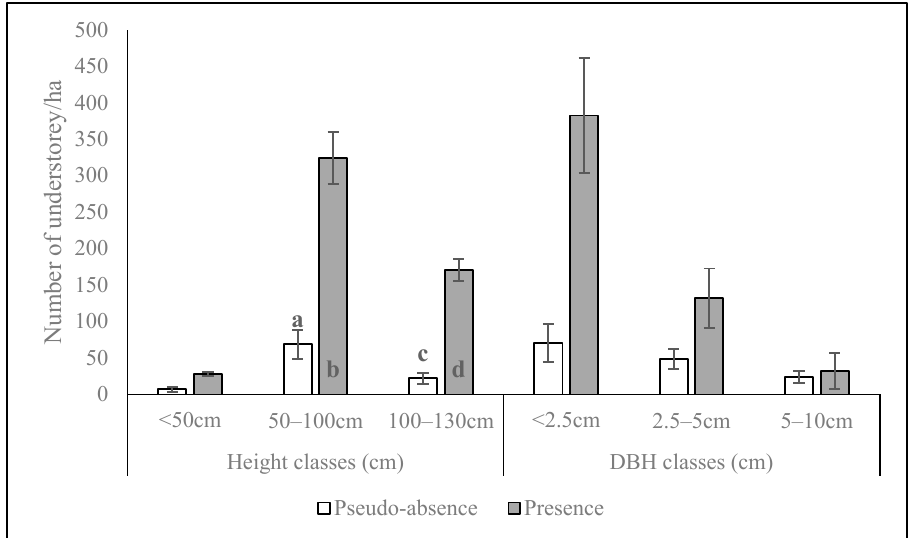
Figure 3. Mean density (±SE) of understorey trees in the different height and DBH classes in the pseudo-absence and presence locations (alphabetic items show a significant difference between two groups.).